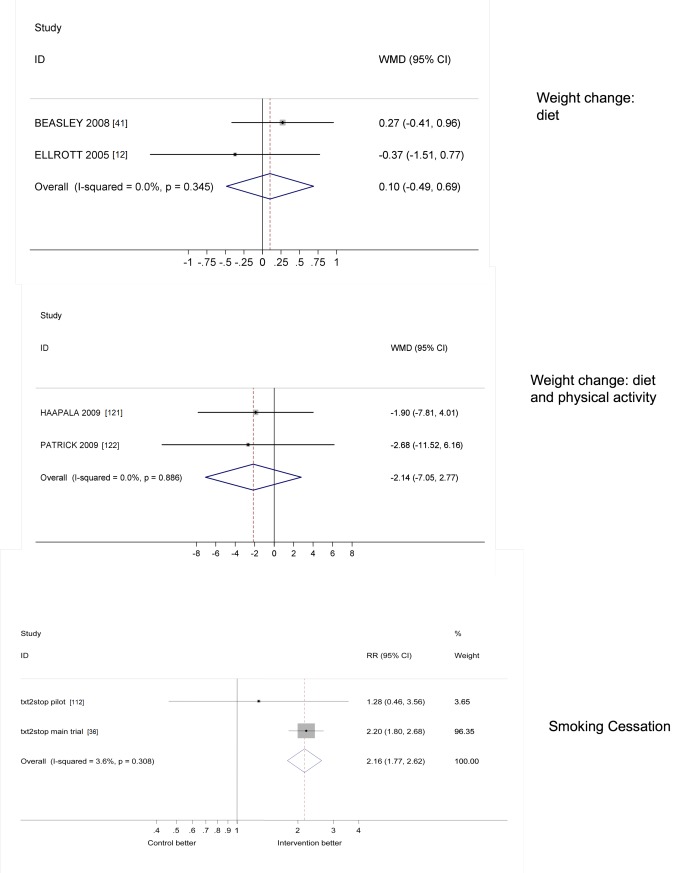
Health behavior change interventions.